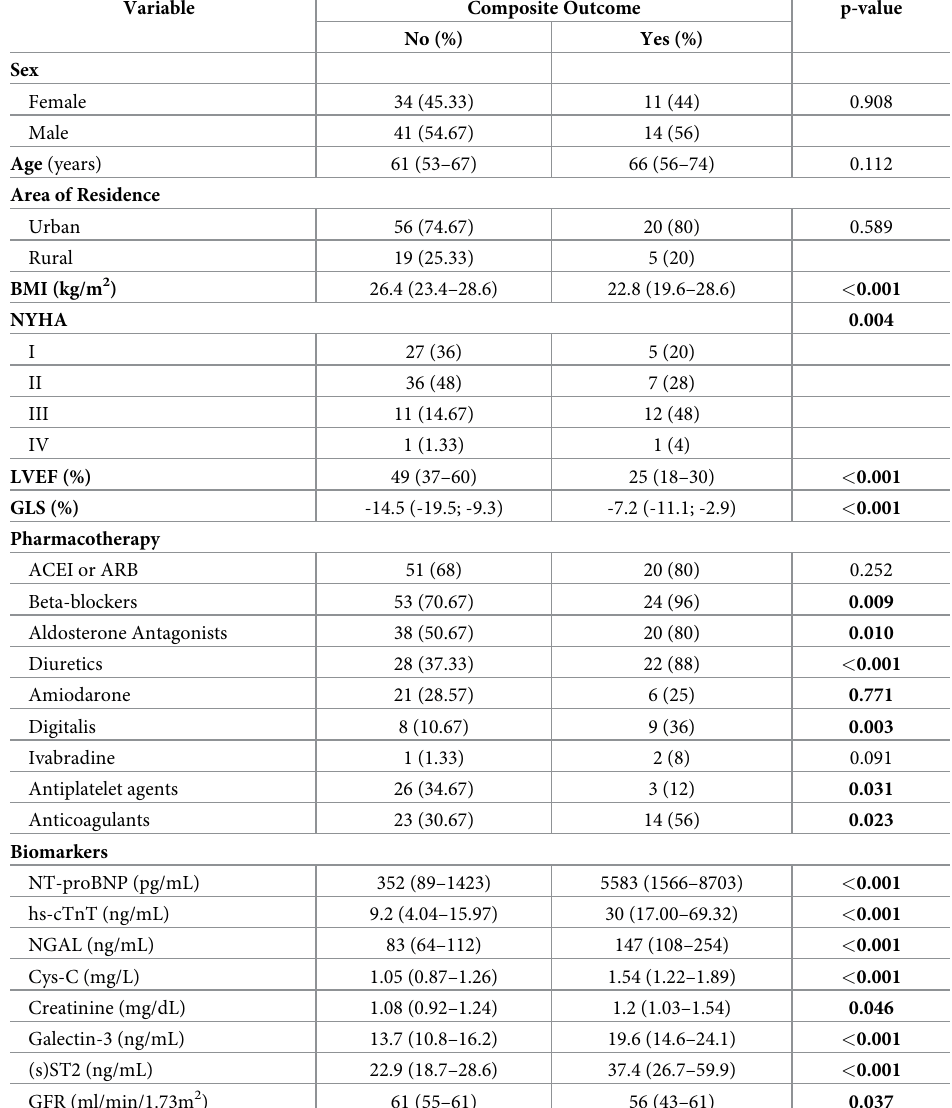
Table 1. Baseline characteristics the evaluated chronic Chagas cardiomyopathy patients (n =